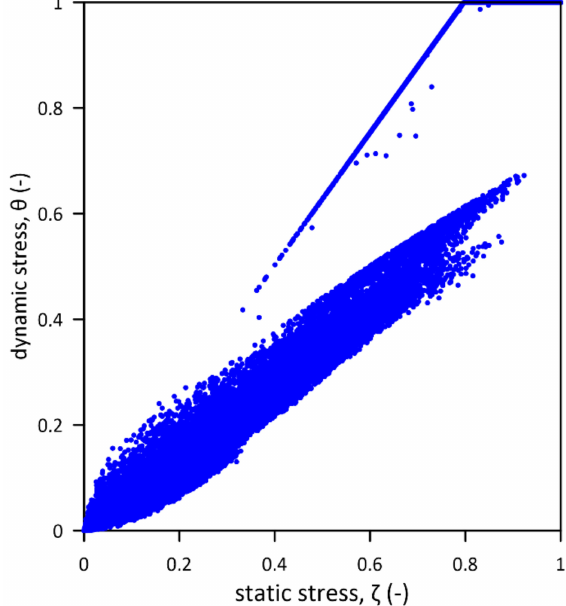
Figure 7. Relation between dynamic and static stress for all sites and studied